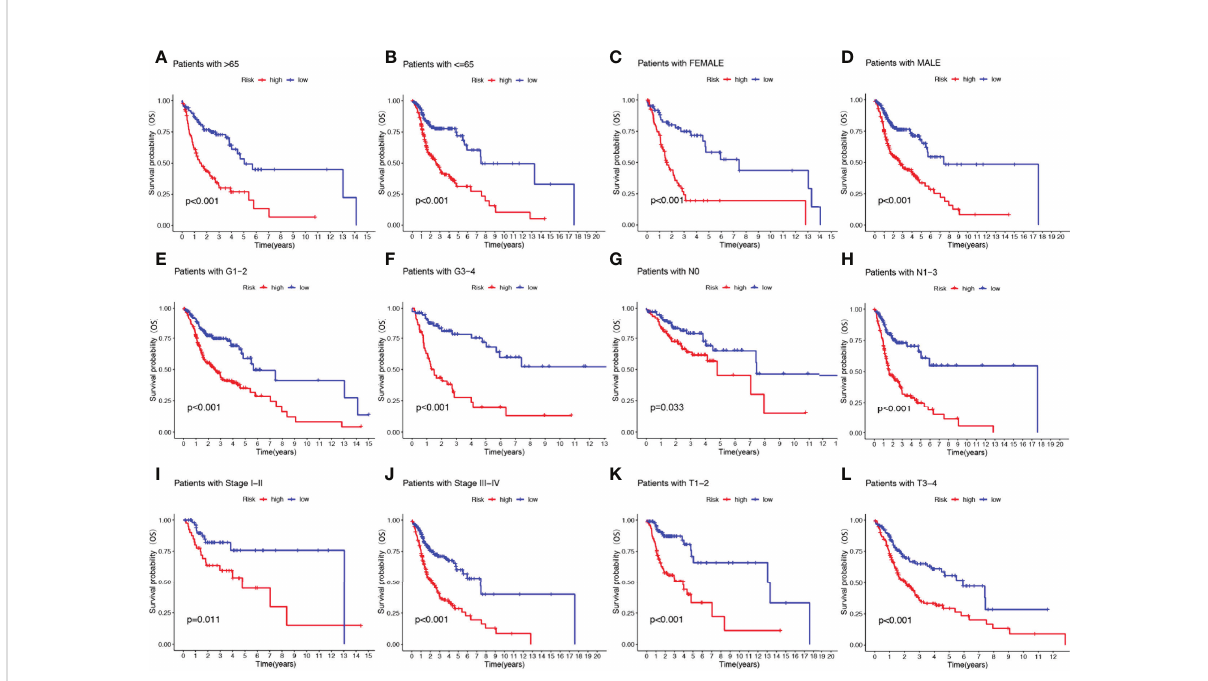
FIGURE 5 The risk score based on 17-NRGs signature is a valuable marker for poor prognosis in various subgroups divided by clinicopathological characteristics. The NRGs could distinguish high-risk patients in a variety of subgroups divided by clinicopathological characteristics including age (A, B) , gender (C, D) , grades (E, F) , N stage (G, H) , tumor stage (I, J) and T stage (K, L)